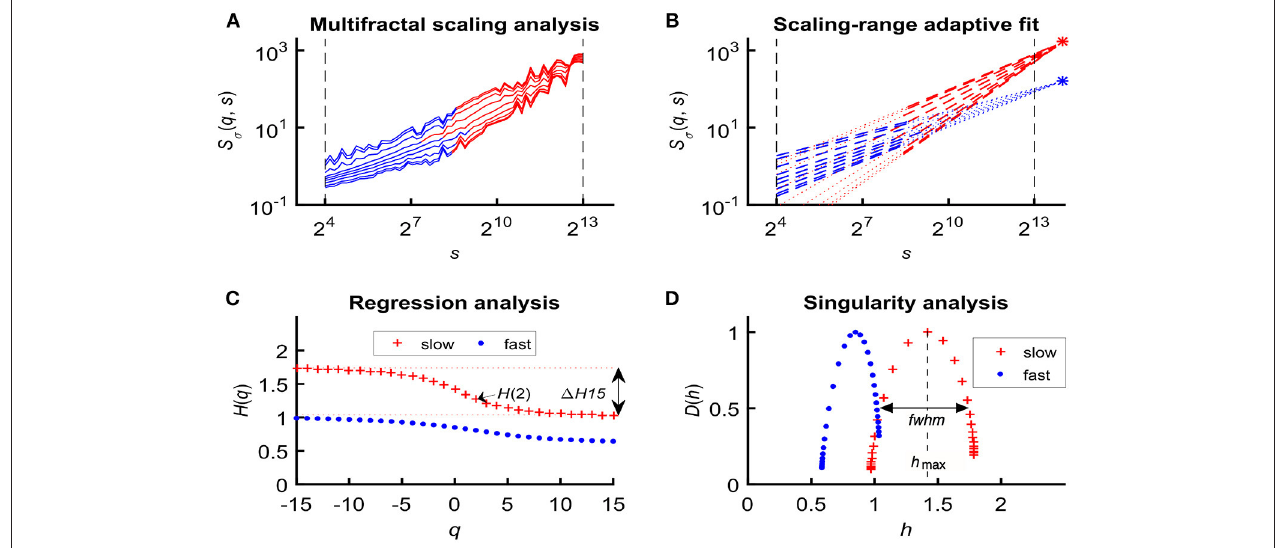
FIGURE 2 | Steps of bimodal multifractal SSC analysis. (A) Scaling function of SSC as moment-wise generalization of variance profiles. Separate components are marked in blue (fast) and red (slow). (B) The sets of power-law functions fitted separately for the two components with focus-based regression. (C) Generalized Hurst exponent functions, H ( q )s of the two components as functions of moment order q . The focus point and H ( q ) for both components ( f , fast; s , slow) were iterated for finding the scale with minimum SSE( s’ ( q )) as the true breakpoint at a given moment, which process finally yields ln ( s ˆS σ ( N )), ln ( f ˆS σ ( N )), s ˆH ( q ), and f ˆH ( q ) with the best fit. (D) Singularity spectra of the two components. Multifractal endpoint parameters : the highest singularity strength ( D = 1) is associated with the maximal Hölder exponent ( h max ), which usually correlates well with H (2), a measure of global LRC in the signal. Distribution of local scale-free behavior is captured in 1 H 15 = H ( − 15) – H (15) and in full-width at half maximum ( fwhm ) of D ( h ) respectively, reflecting degree of